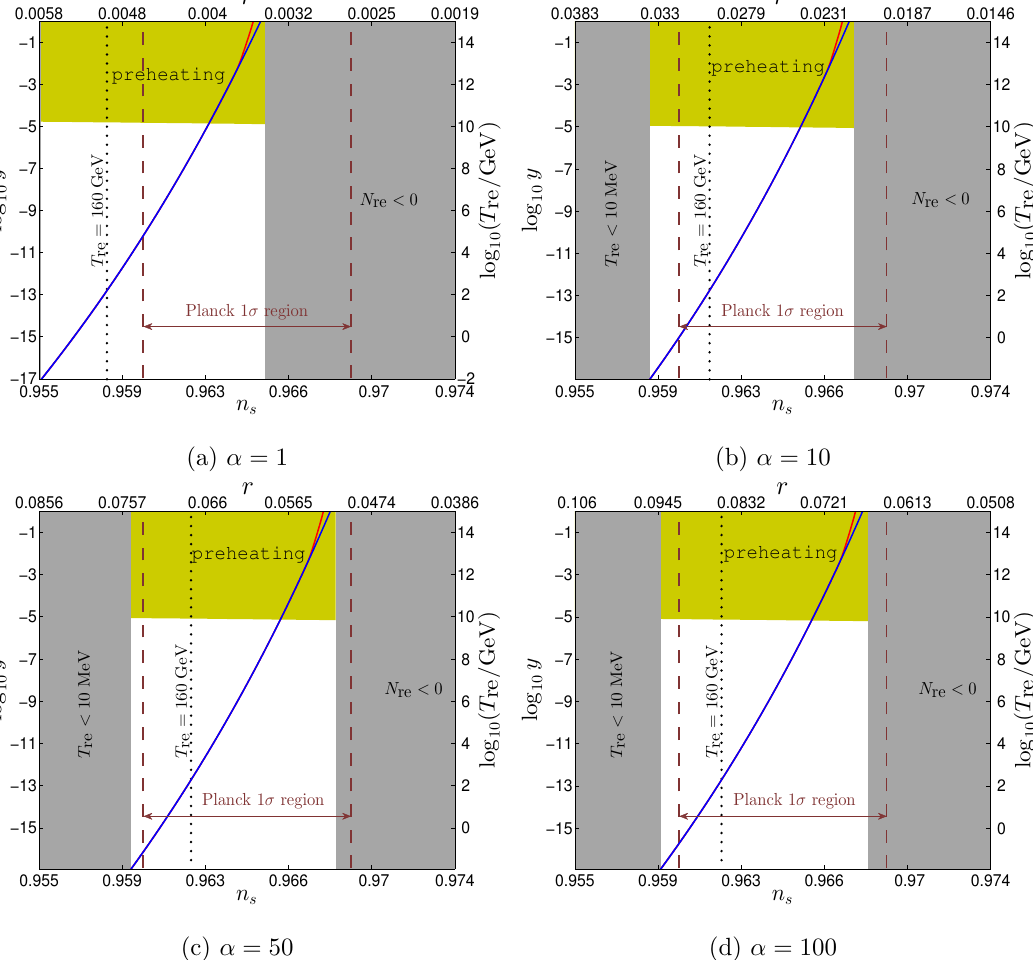
Figure 13. Spectral index dependence of the Yukawa coupling. The solid lines are plotted from eqs. (3.40) (blue line) and (3.42) (red line) for various values of (cid:11) . The parameter choices and notations are the same as in (cid:12)gure 7. The yellow regions denoted by \preheating" correspond to resonance regimes where the perturbative treatment of reheating is not